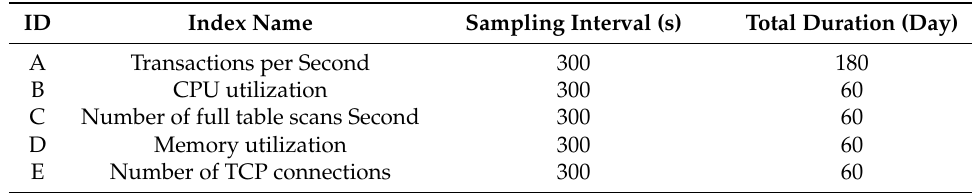
Table 6. KPI indicator statistics of experimental dataset.